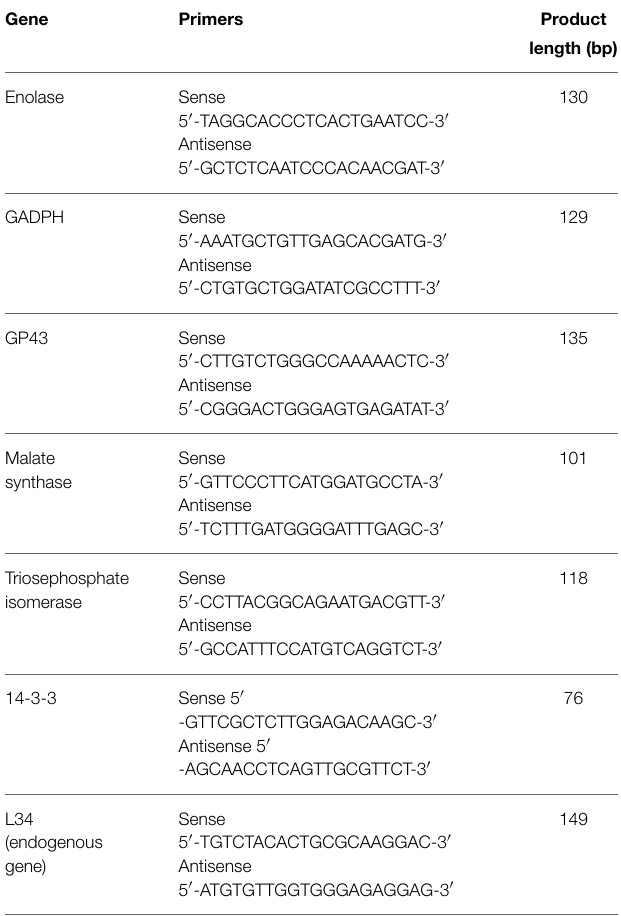
TABLE 1 | Primers used for the real-time PCR